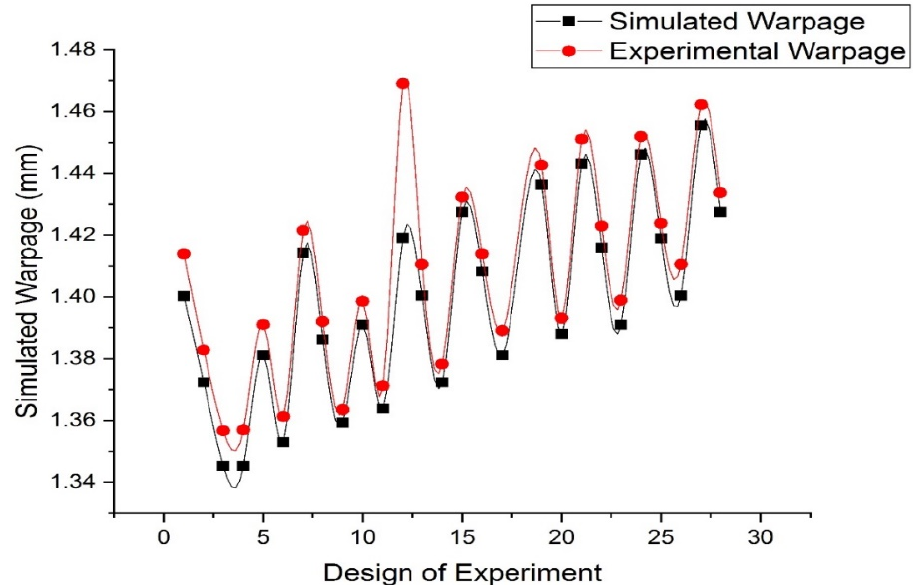
Figure 12. Validation of Simulated Results with Experimental Results .